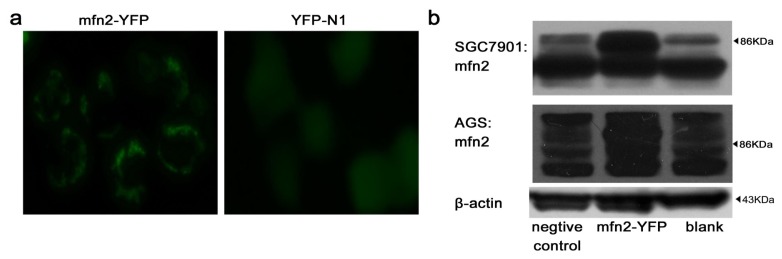
Transfection: (a) Gastric cancer cell line SGC7901 was transfected with Mfn2-YFP (left) or YFP-N1 (right); (b) Western blot analysis confirmed that the expression of Mfn2 increased significantly both in SGC7901 and AGS after they were transfected with Mfn2-YFP.